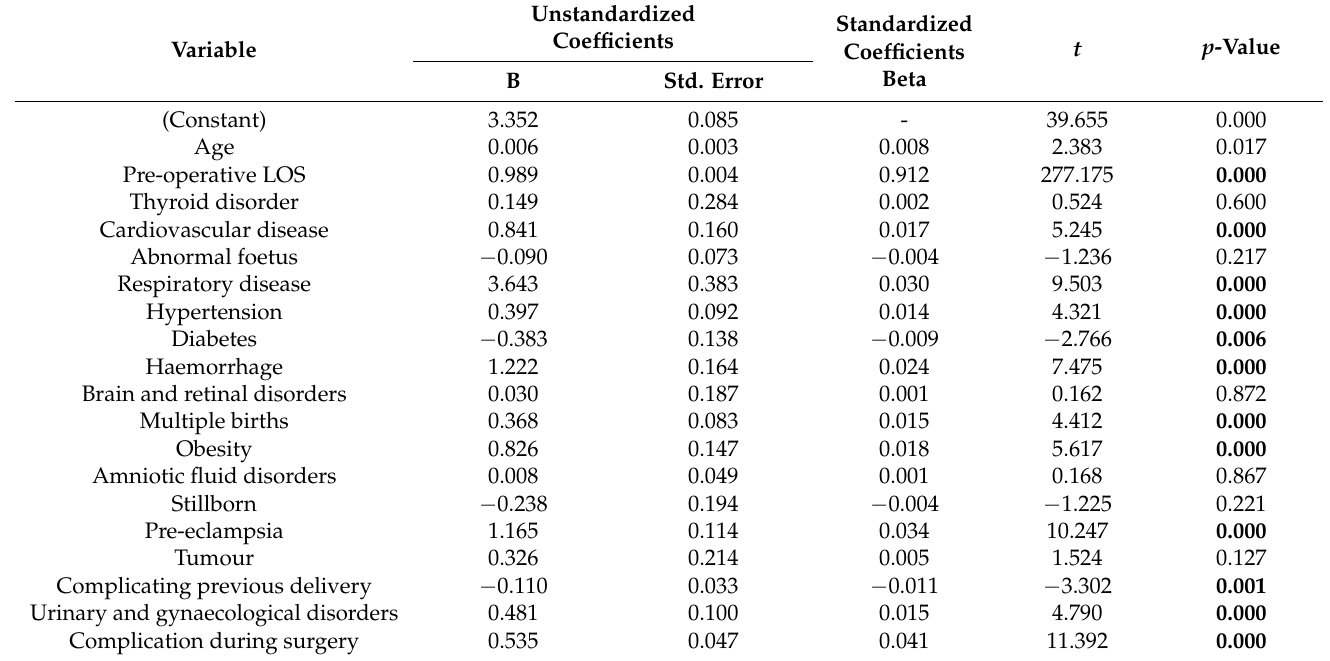
Table 4. Coefficients and results of t -test for the multiple linear regression model.